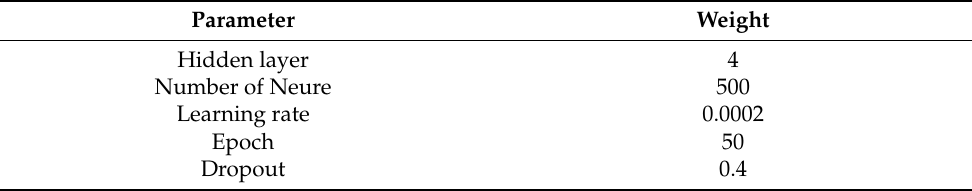
Table 3. DNN model